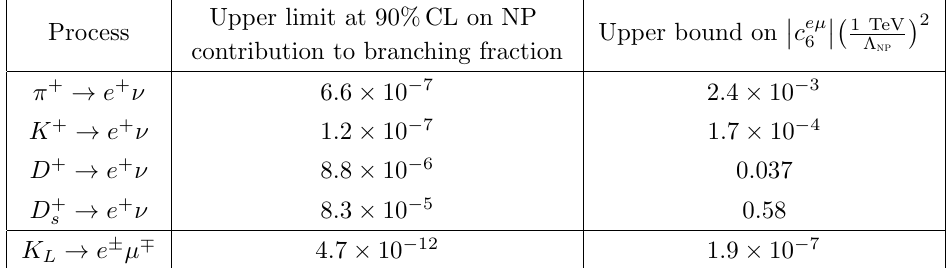
from processes without hyperons 6 ; 6 0